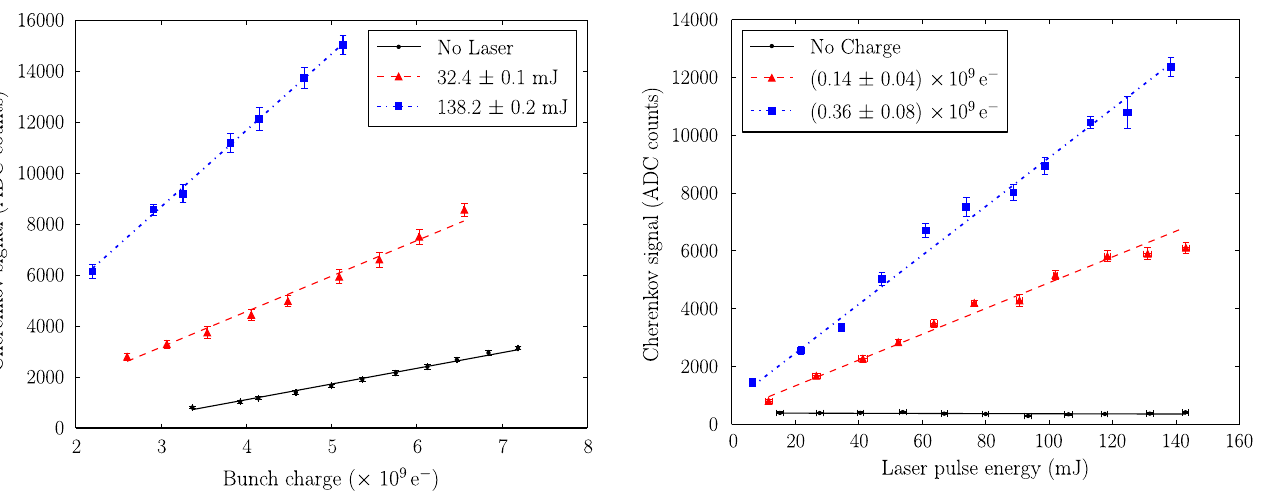
FIG. 16. Variation of the Cherenkov signal with electron bunch charge for various laser levels.